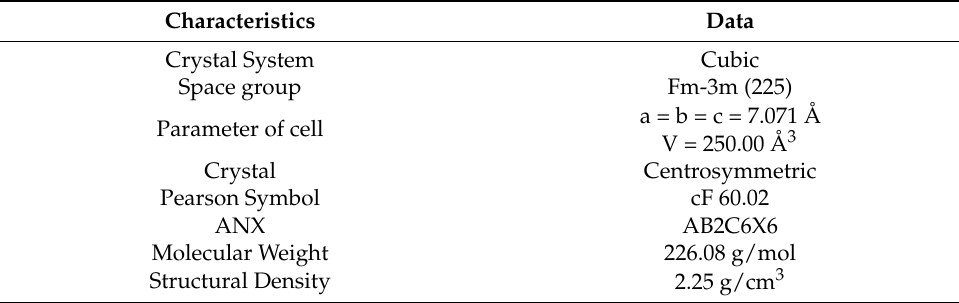
Table 2. Crystal cell parameters of